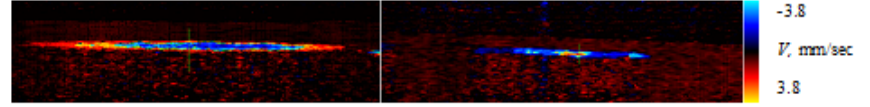
Fig. 3. The velocity map of left branch of sagittal vein before (a) and after (b) adrenaline infusion in newborn rat.